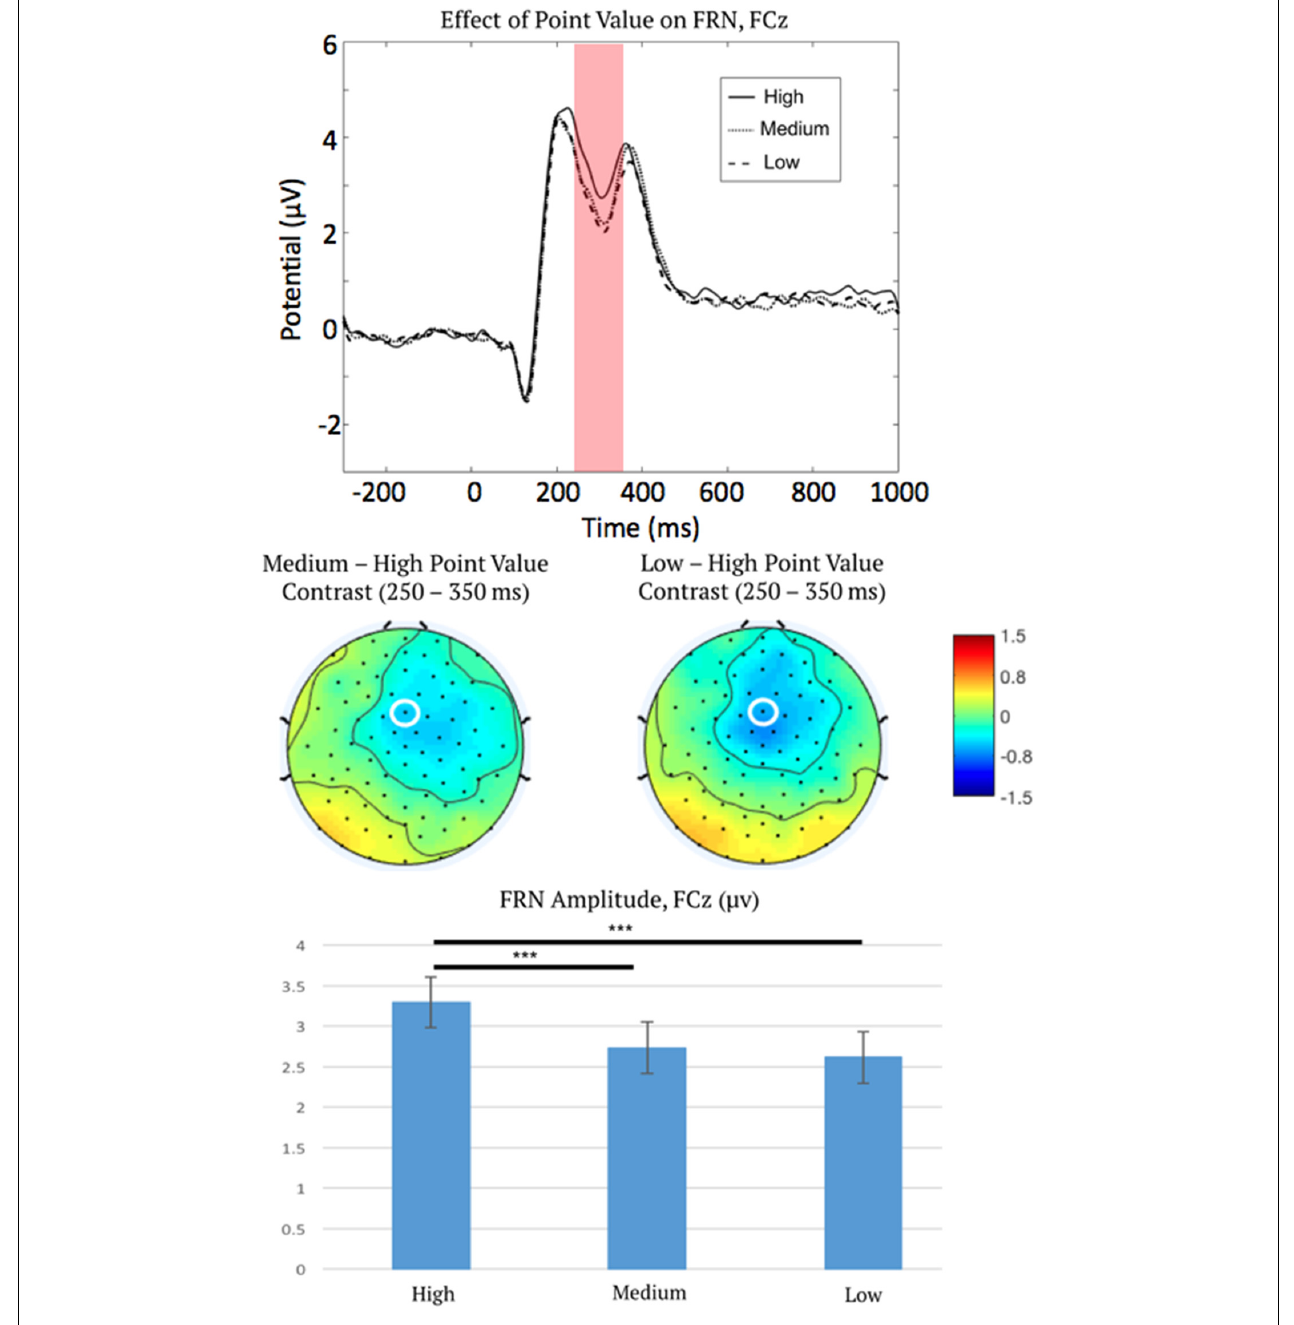
FIGURE 3 | Event-related potential (ERP) waveforms measured at FCz (top), topographic distributions of the medium-high and low-high difference in the feedback-related negativity (FRN) time window (middle), and mean FRN amplitudes (bottom), showing the main effect of point salience on the FRN. This plot describes the main effect of point level as confirmed via ANOVA, therefore all ERP waveforms are collapsed over the correct and error outcomes, and positive and negative reinforcement. Note ERPs are plotted negative downward, such that larger FRN activation is depicted as a waveform drop. FCz is marked by a white ellipse. The shaded region is the time period across which the FRN was measured. Error bars represent 1 ± SEM. ∗∗∗ p < 0.001.